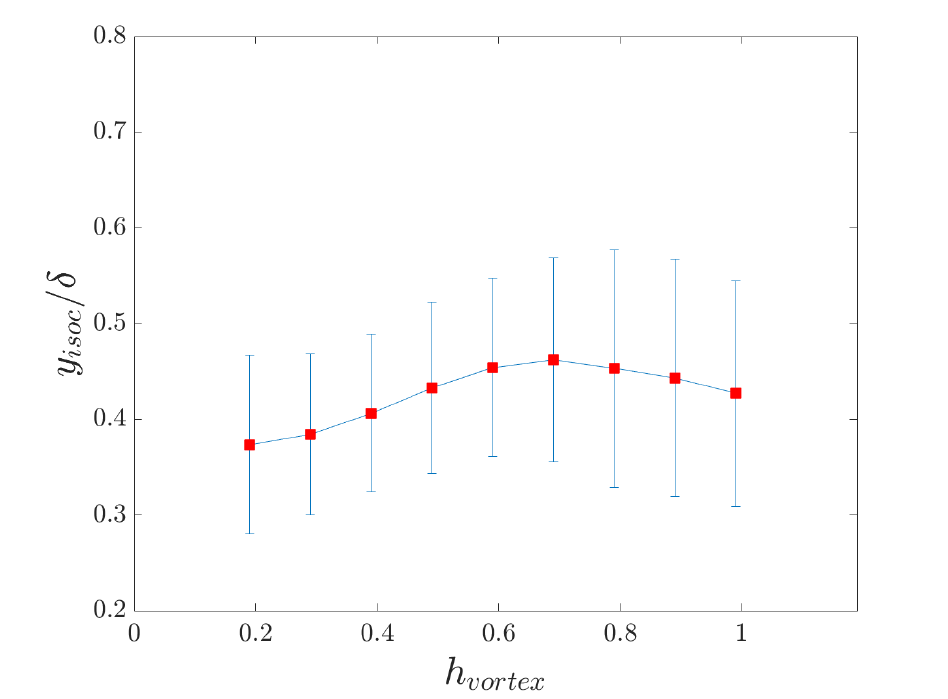
Figure 7. The height of the large-scale streamwise velocity isocontour at U l = 0.8 U ∞ against height of the coherent vortices. The red squares indicate the mean height of the isocontour for a given y v while the blue lines indicate the standard deviation of the isocontour